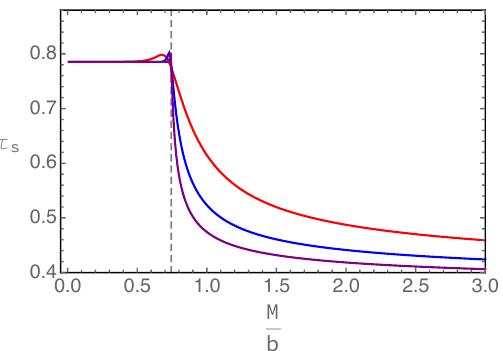
Figure 4 . Plots of the proper time τ s from the horizon to the singularity as a function of M/b at different temperatures T/b = 0 . 05 (red), 0 . 02 (blue), 0 . 01